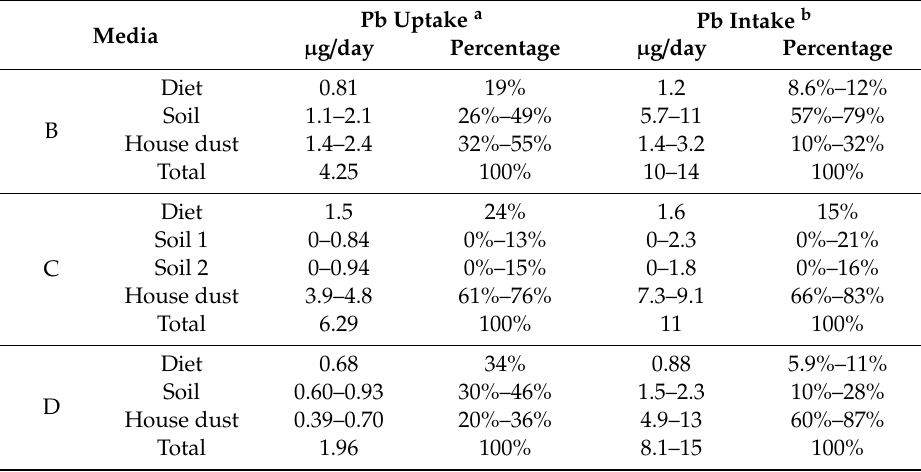
Table 5. Range of source apportionment estimates from linear